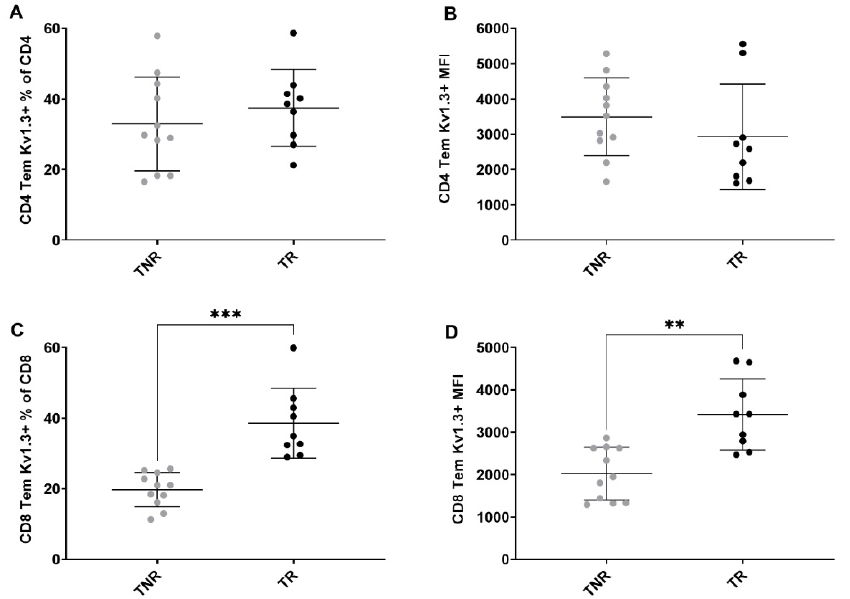
Figure 5. Multicolour flow cytometry analysis of tumour-associated Kv1.3-expressing T cells after treatment. Percentages of ( A ) Kv1.3 CD4 + T EM cells relative to total CD4 + cells ( B ) CD4 + T EM cells relative to total CD4 + cells MFI ( C ) Kv1.3 CD8 + T EM cells relative to total CD8 + cells MFI ( D ) Kv1.3 CD8 + T EM cells relative to total CD8 + cells MFI between TR and TNR. Data are shown as individual values with the mean ± S.D. and are representative of n = 8–10 mice/ group. ** p < 0.01; *** p < 0.001 TR compared to TNR.